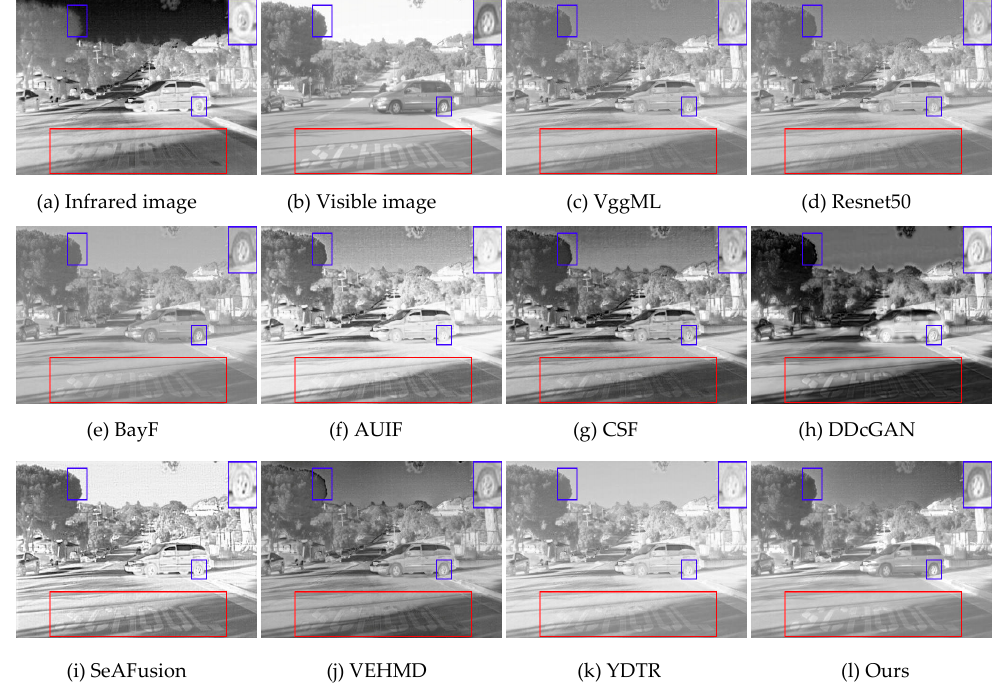
Figure 5. Fused images using ten different methods when the source image is “FLIR_video_05245”.